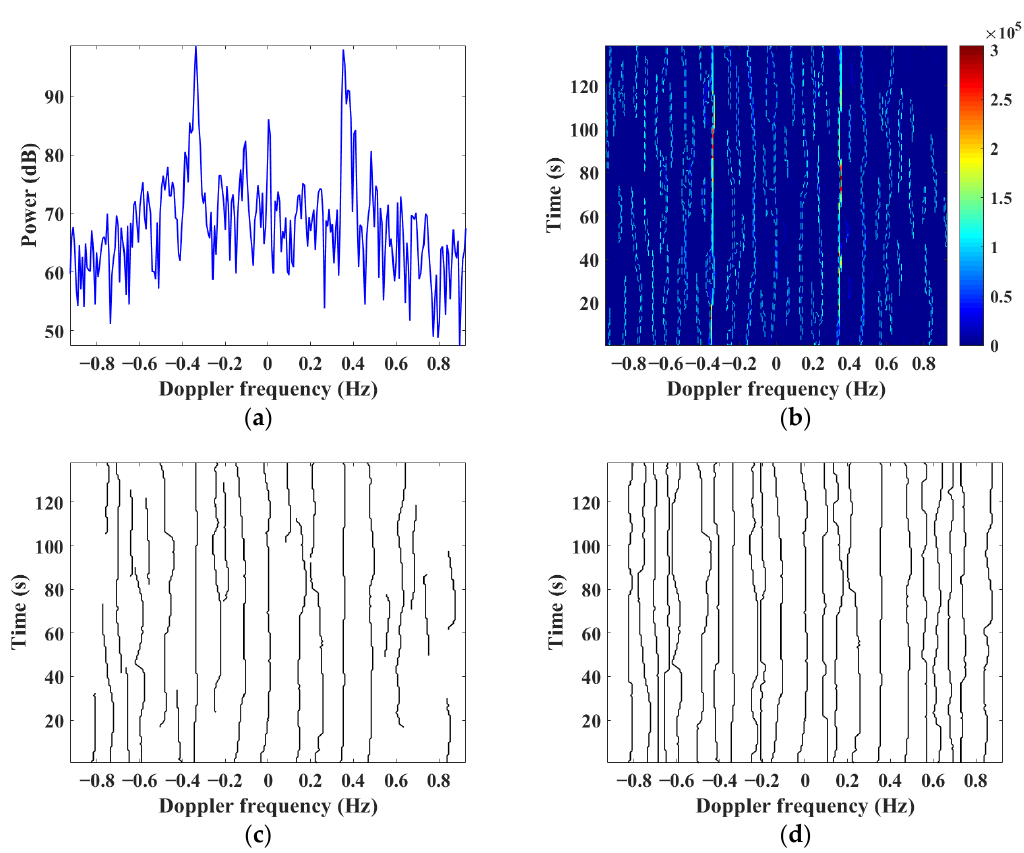
Figure 2. Power spectrum, TF image, and ridge extraction of radar signal at 18th range bin at 01:11 on 5 October 2015. ( a ) power spectrum; ( b ) the regions of ridges marked by Hessian matrix; ( c ) the extracted discontinuous TF ridges; ( d ) the extracted continuous TF ridges.